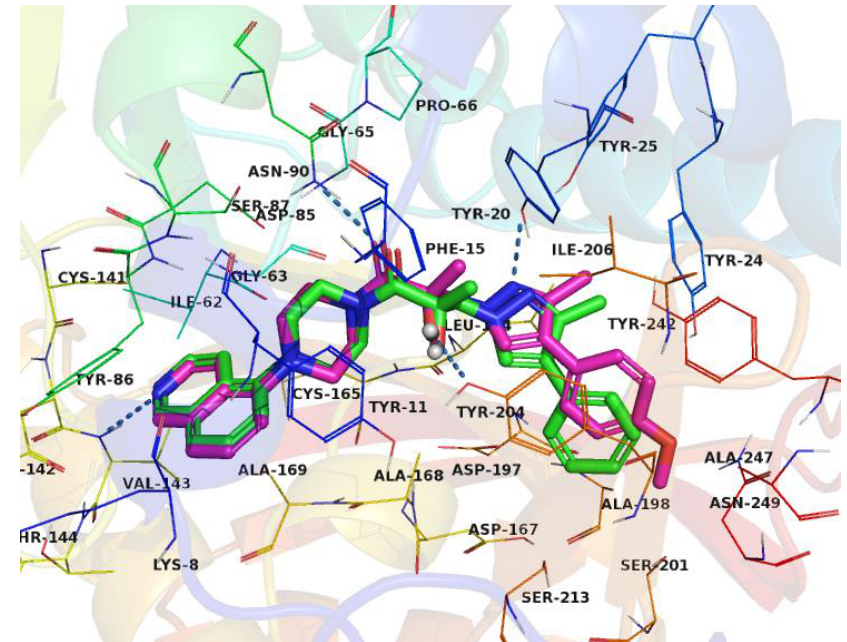
Figure 8. Predicted binding mode of compound 12 (magenta), along with the crystal structure of compound 1 (green), co-crystalized in hNNMT. The blue dashes are the polar interactions of compound 12 with the binding site amino acids. The figure was made using PyMOL v0.99.